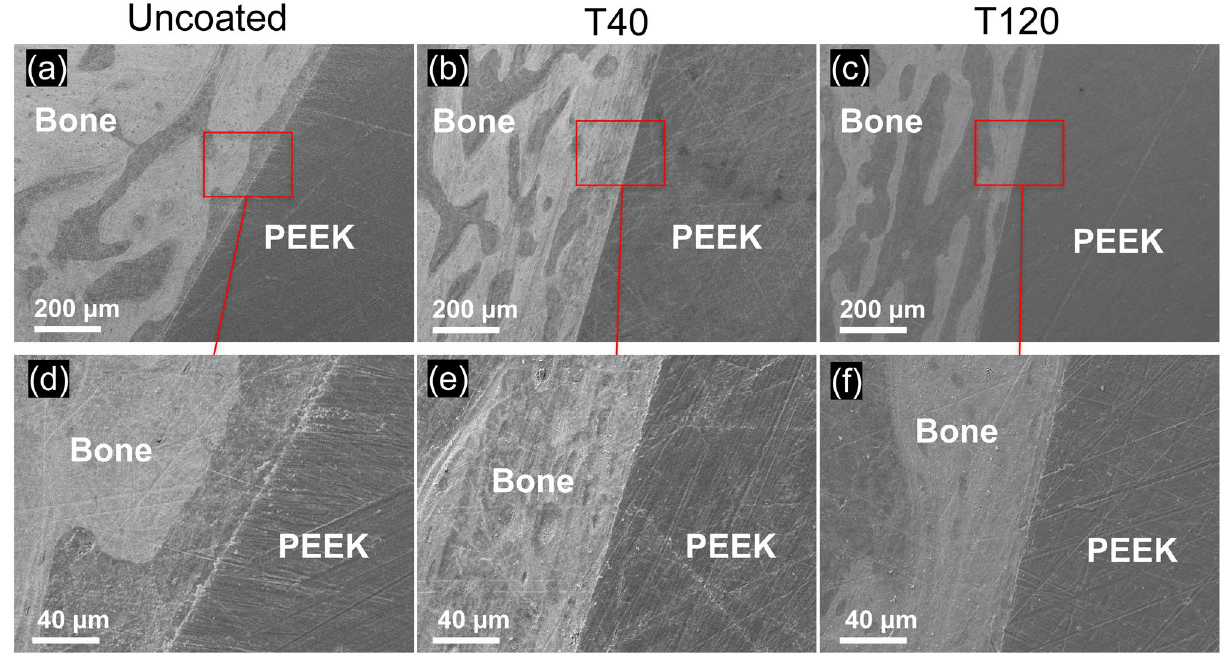
Figure 5. SEM images of the histological section at 12 weeks: ( a , d ) uncoated implant (direct bone-implant contact was scarcely observed); ( b , e ) T40 implant (bone-implant integration was observed); ( c , f ) T120 implant (bone-implant integration was